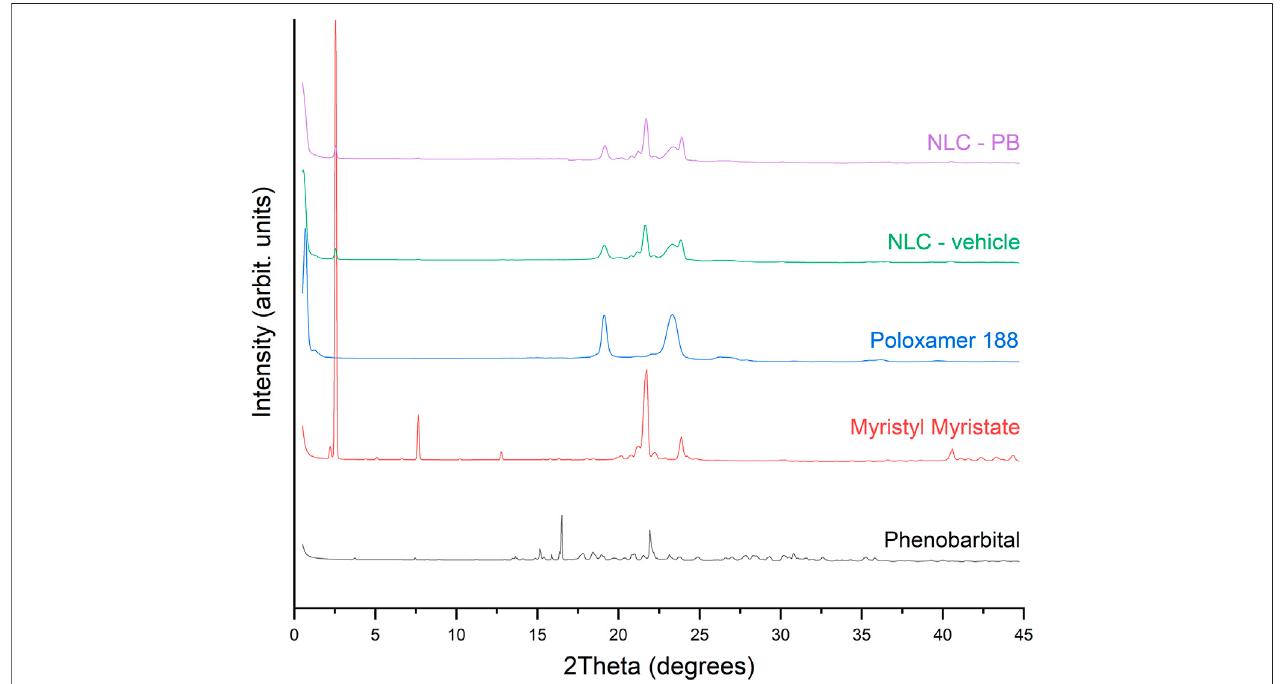
FIGURE 6 | XRD patterns of raw materials and nanoparticles with and without phenobarbital. Note: Y -axis scale is the same for all x-ray diffraction patterns.